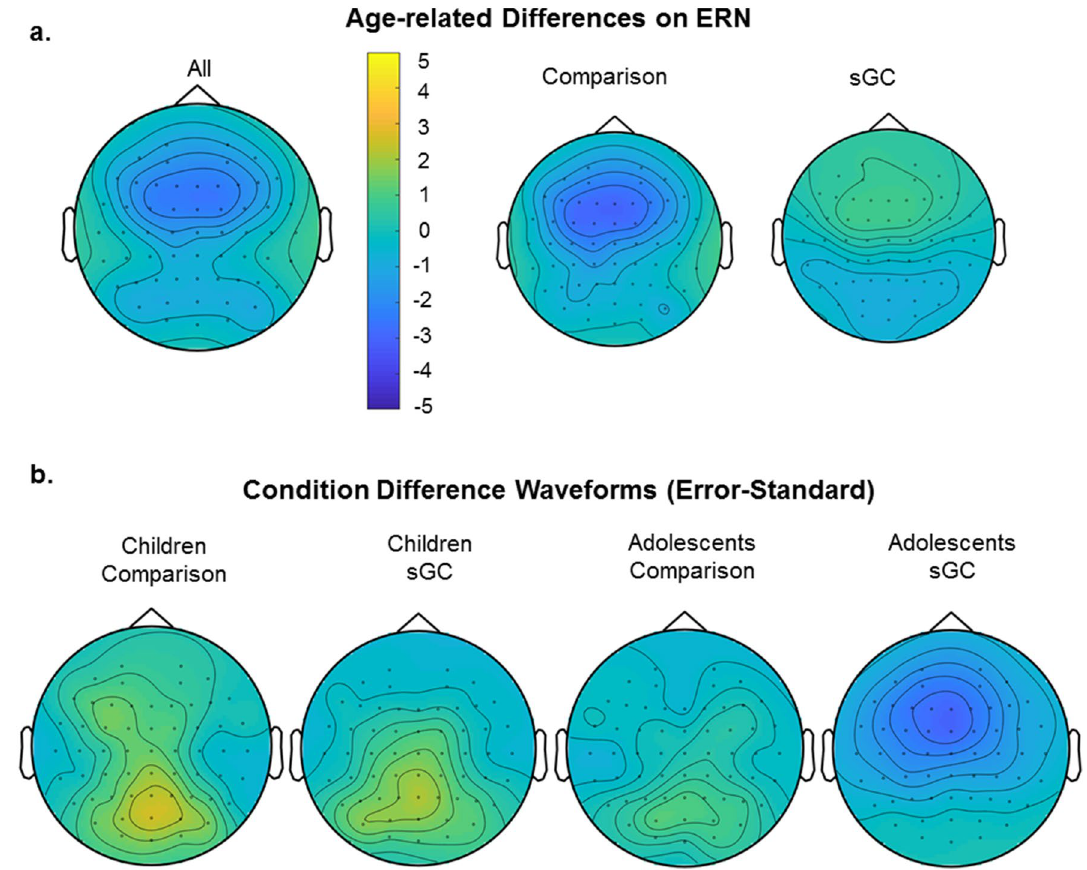
Figure 4. ( a ) Error-related ERN amplitudes showed maximal age-related difference at the fronto-central electrodes (in particular, electrode FCz) between 50 ms prior to 100 ms after the onset of stimulus; Topographical maps showing maximal condition difference for children in the comparison group, children in the sGC group, adolescents in the comparison group and adolescents in the sGC group at peak latency (± 25